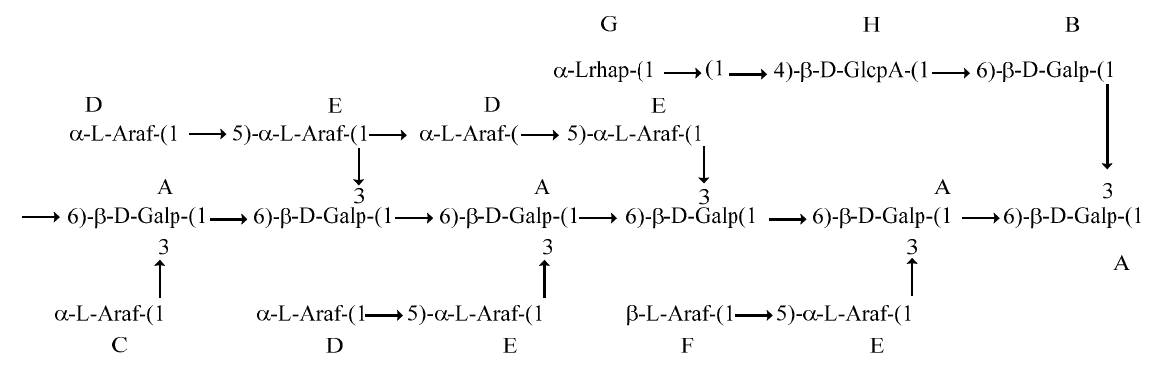
Figure 14. The chemical structure of LBPA.